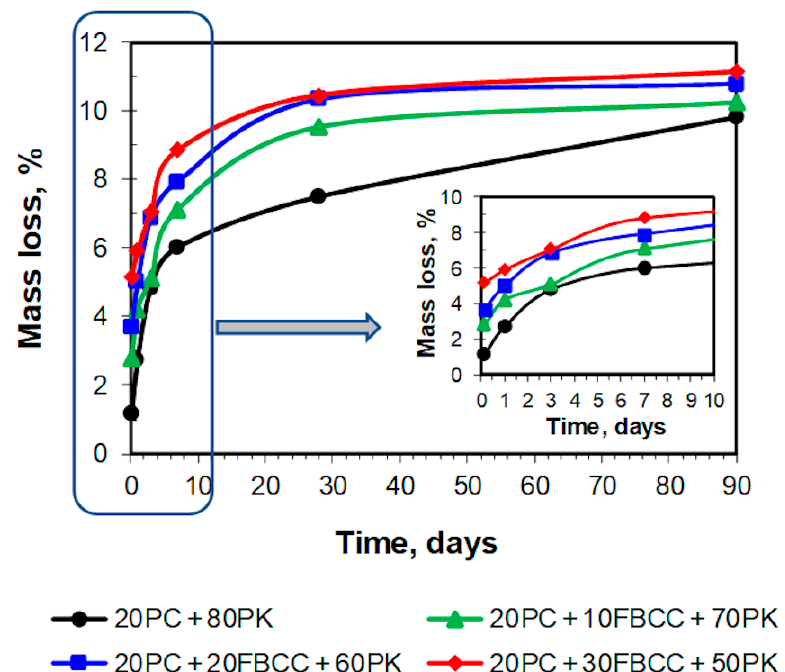
Figure 6. Mass loss relating to water bound in hydrates, such as C-S-H, C-A-S-H, sulfoaluminates, etc.